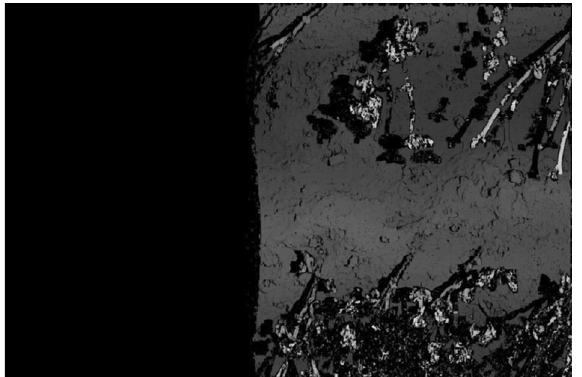
Figure 16. Disparity map obtained from the two images shown in Fig. 15.